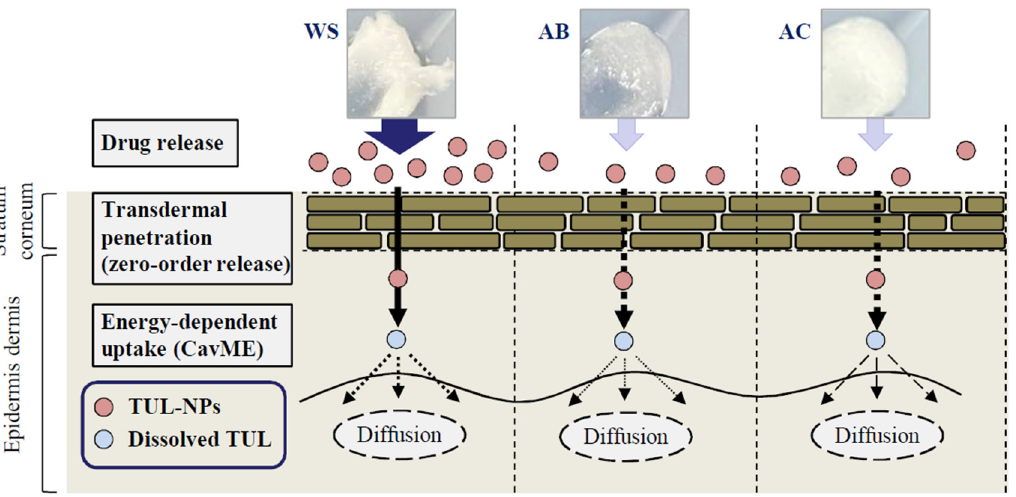
Figure 7. Suggested mechanism for the transdermal penetration process of TUL from ointment bases incorporating TUL-NPs and l -menthol.